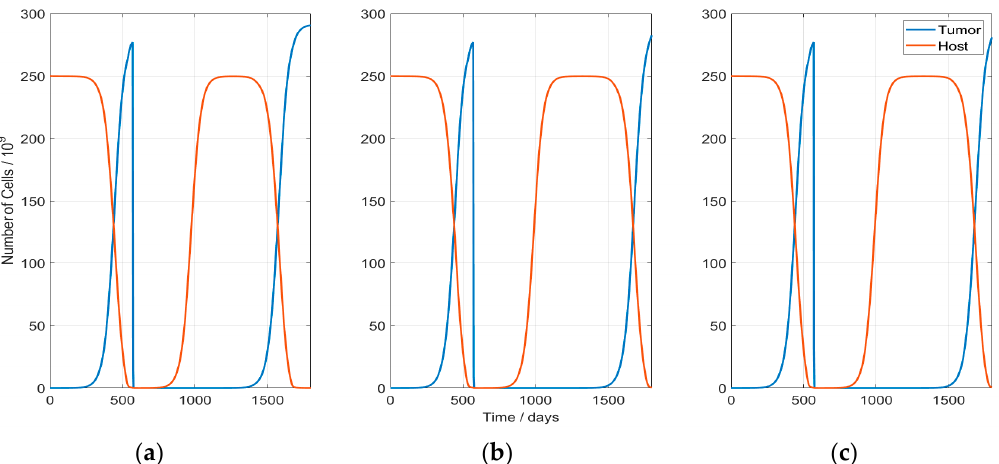
Figure 3. Development of the host—and tumor—cell populations: The sudden drop in the tumor population indicates the time point of RT start (day 570). After RT, the tumor starts to regrowth and approaches in every scenario the equilibrium level of 306 × 10 6 cells. The scenarios presented here correspond to: ( a ) Case with no HT (RT1HT0); ( b ) Case RT1HT3; ( c ) Case RT1HT2.